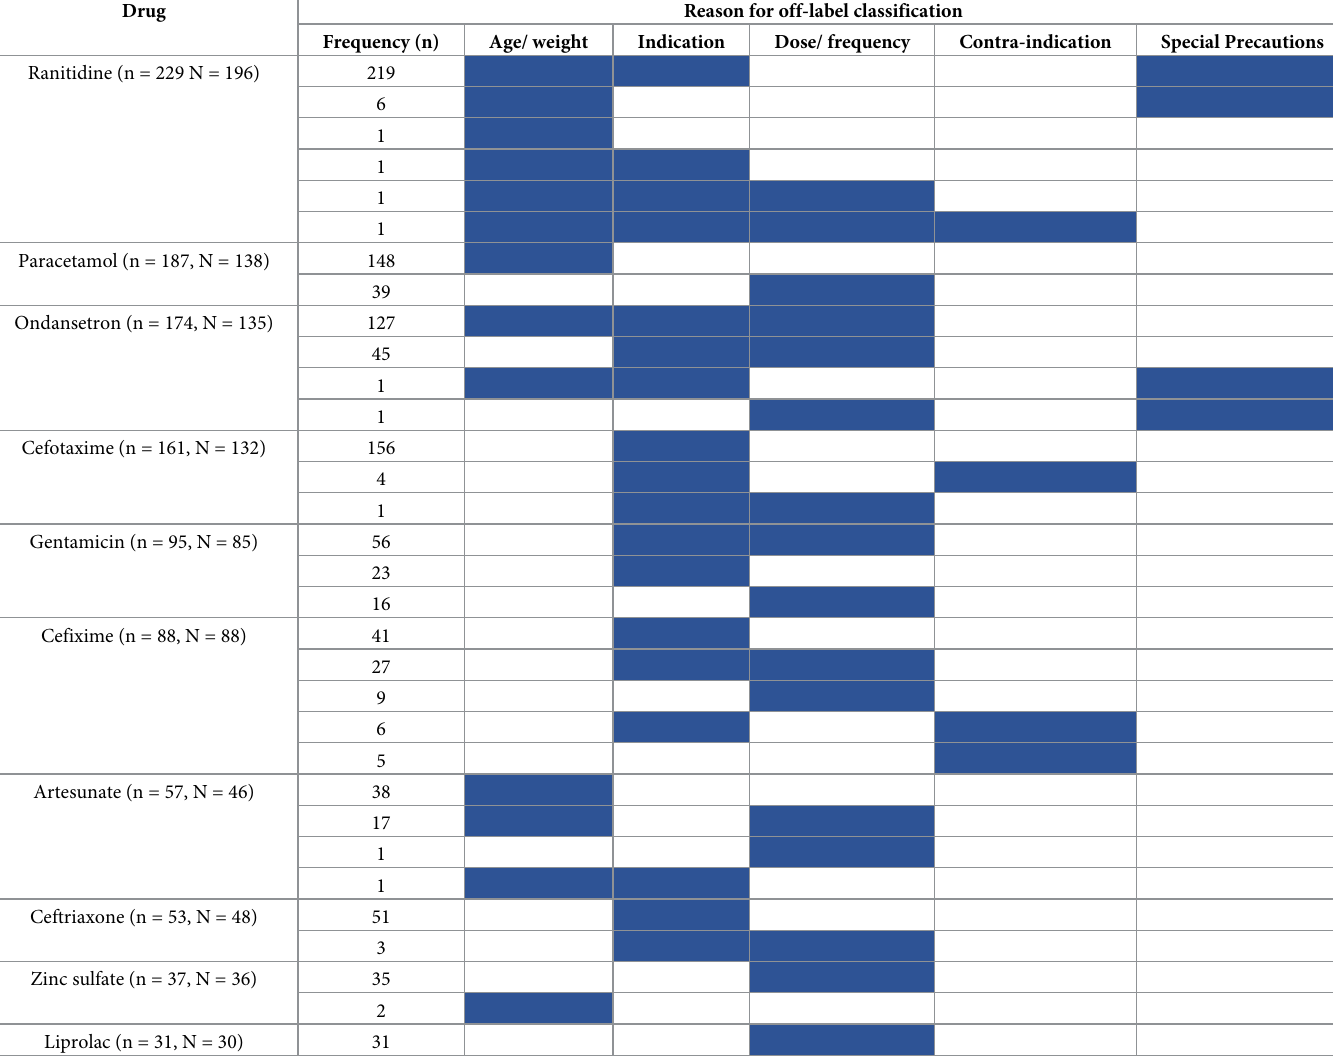
Table 2. The reasons, or particular combination of reasons, for off-label use of the ten most common medicines shown in Table 1. Under each drug name are the number of prescriptions (n), and the number of patients (N).